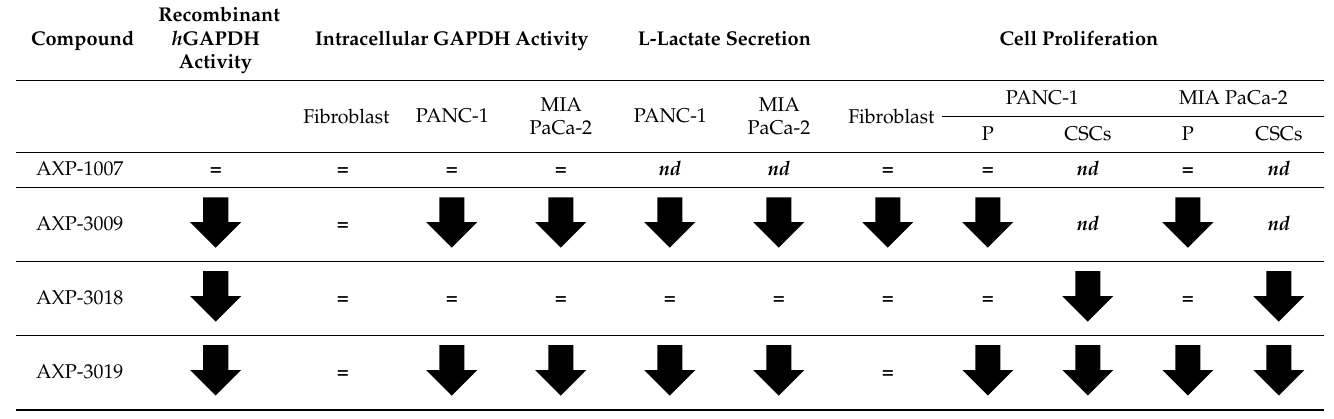
= no significance